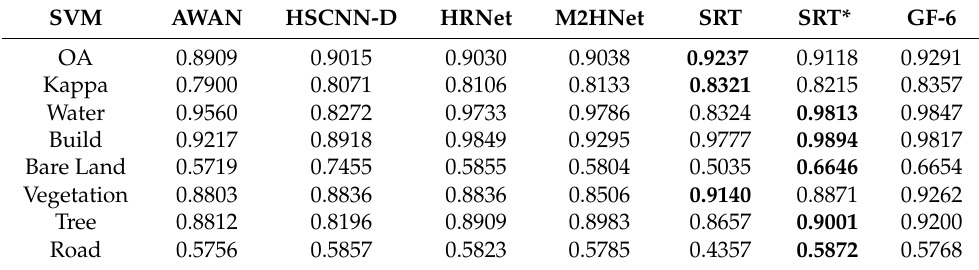
Table 5. Accuracy of classification result of Area1 with SVM. The best results are shown in